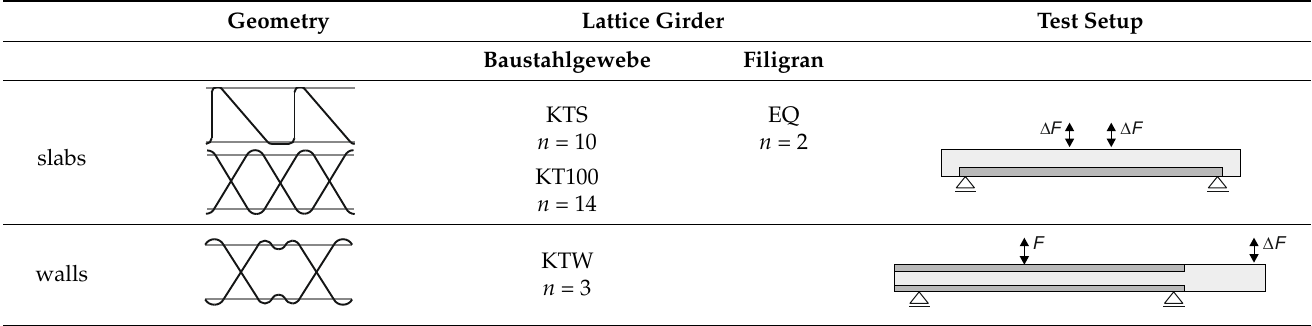
Table 1. Fatigue tests with lattice girders from literature.